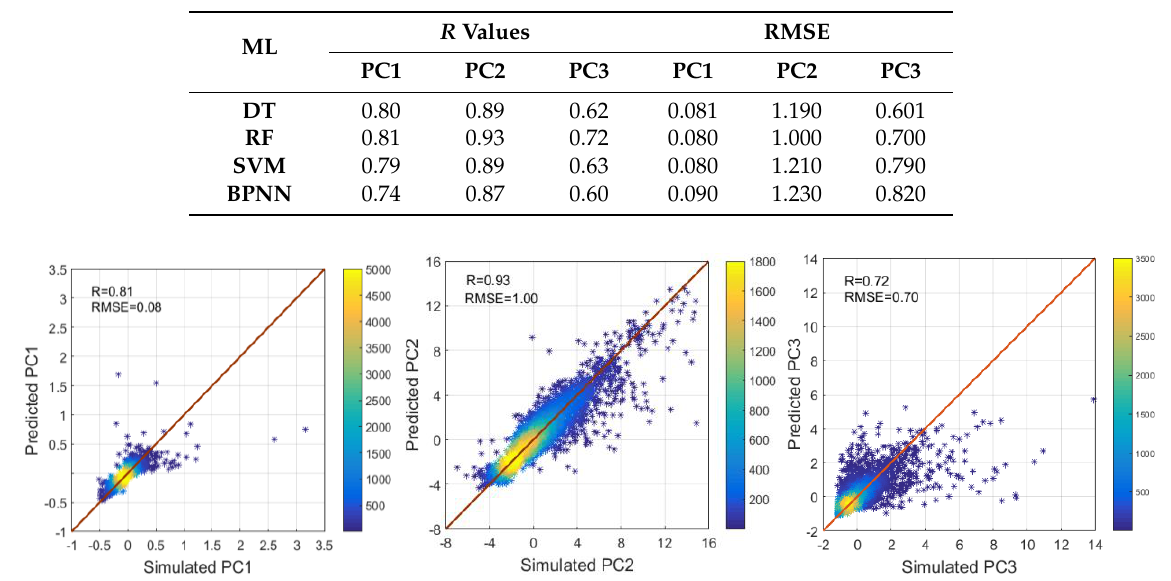
Figure 3. Predicted performance of the first three principal components (PC1, PC2, PC3) by the machine learning algorithm model of random forest (RF) versus the simulated results of computation-ready, experimental metal–organic framework membranes (CoRE-MOFMs) on the test set. The color of the point represents the amount of